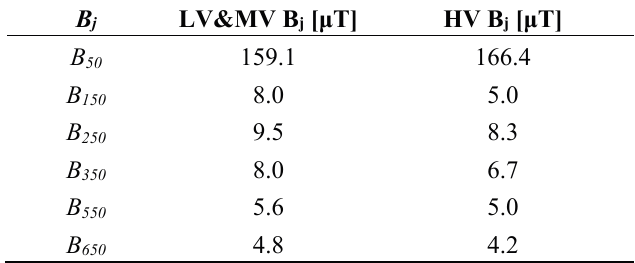
Table 3. Magnitude of the maxima magnetic flux density harmonic components applied in this